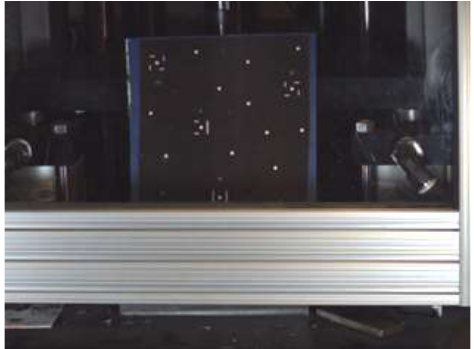
Figure 4. Calibration board positioned inside the impact test machine.